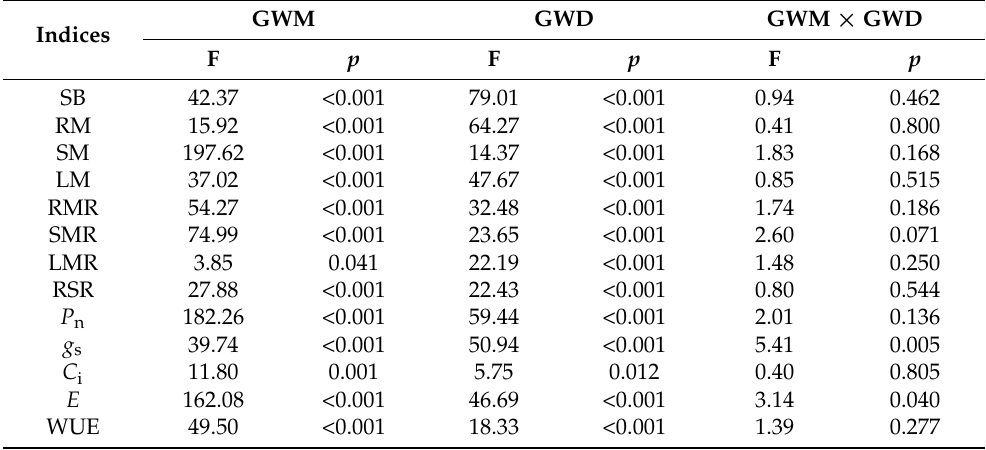
Table 1. Two-way ANOVA analyses of the effects of GWM and GWD their interaction on biomass, biomass allocation, and photosynthetic characteristics of R. pseudoacacia saplings.